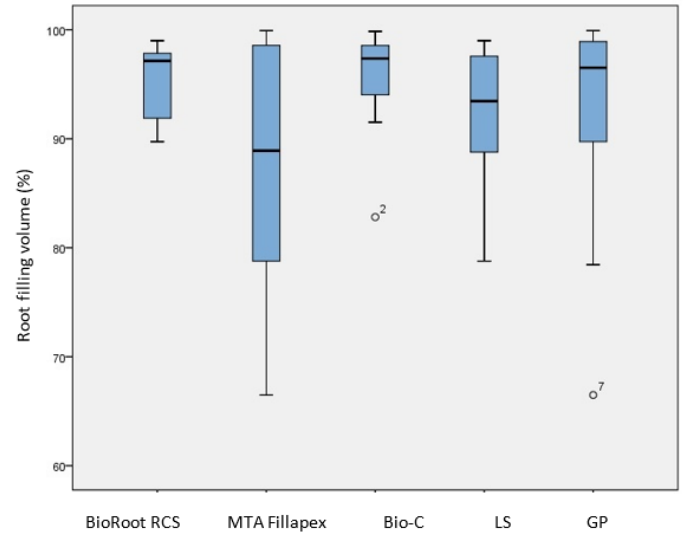
Figure 2. Comparison of the percentage of root filling after single GP cone obturation with different CSBSs and different sealer application methods (LS and GP). No significant differences were found between any of the groups ( p > 0.05).